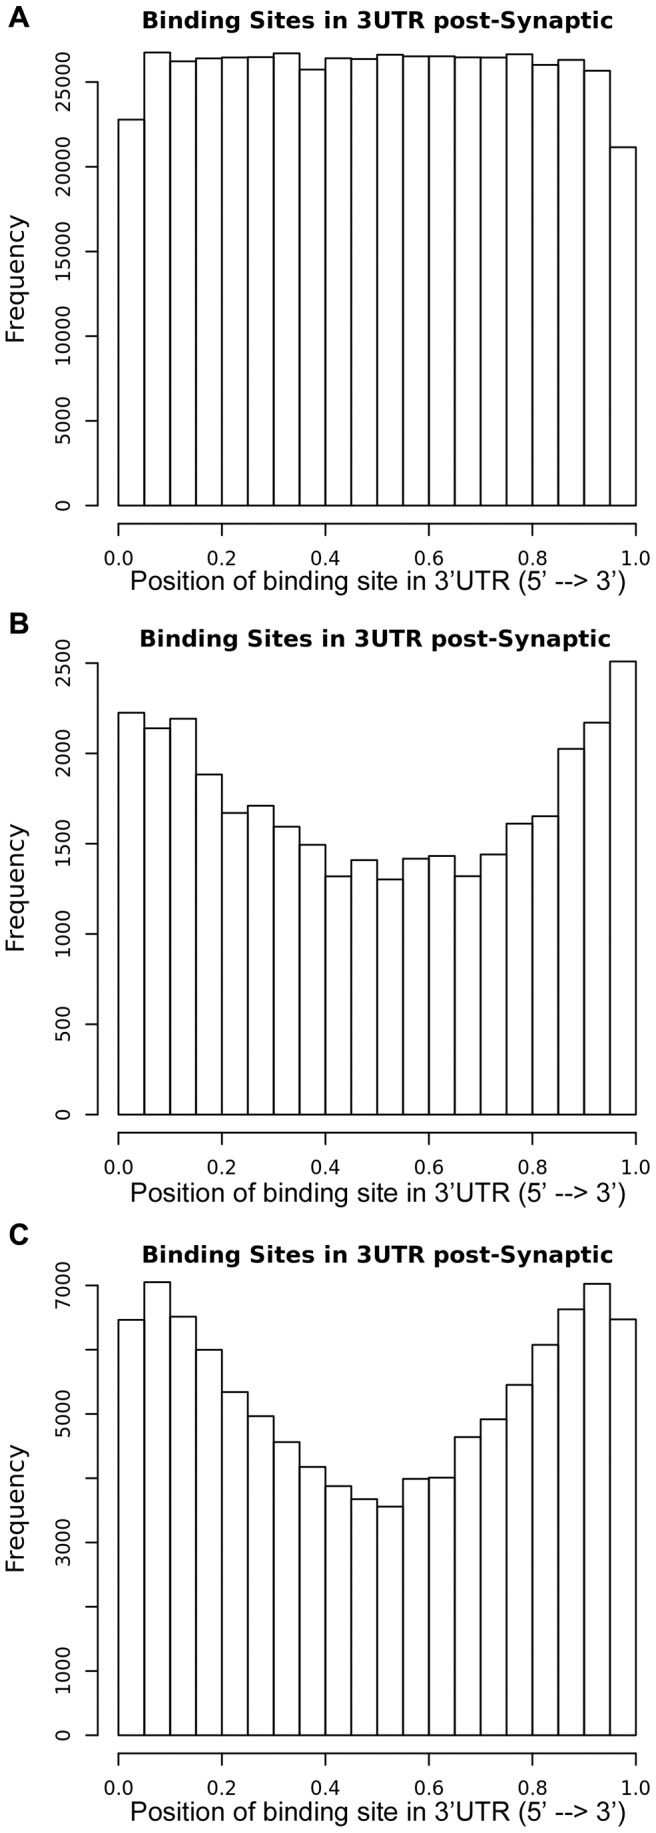
Relative position of miRNA binding sites.Relative position of miRNA binding sites (as percentile of 3′UTR sequence) in postsynaptic genes (A) without the use of a threshold in the target prediction results, (B) using DIANA-microT-CDS at a threshold of 0.9, and (C) using TargetScan v6.0 at a threshold of 0.